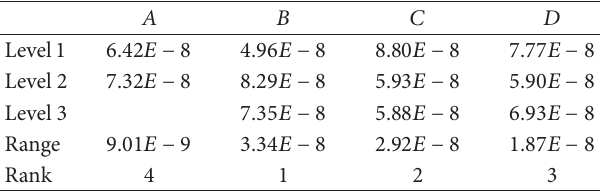
Table 3: The response table in 𝑌 -direction (unit: